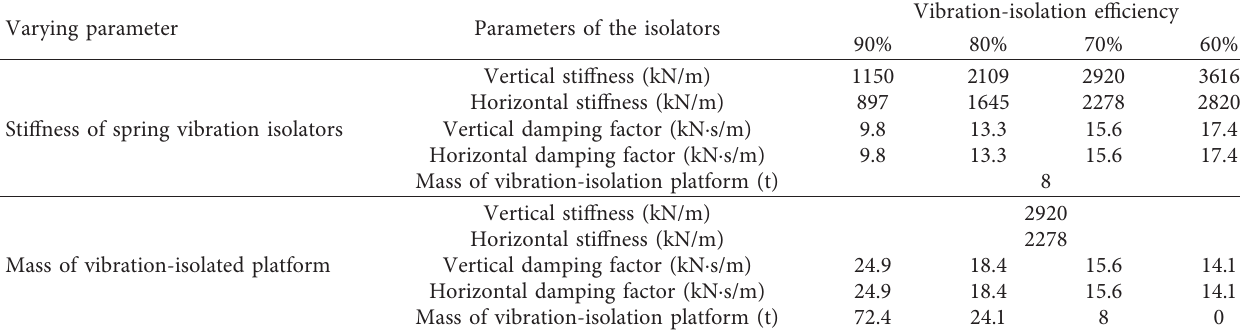
Table 8: Parameters of spring vibration-isolation system under each vibration-isolation efficiency.